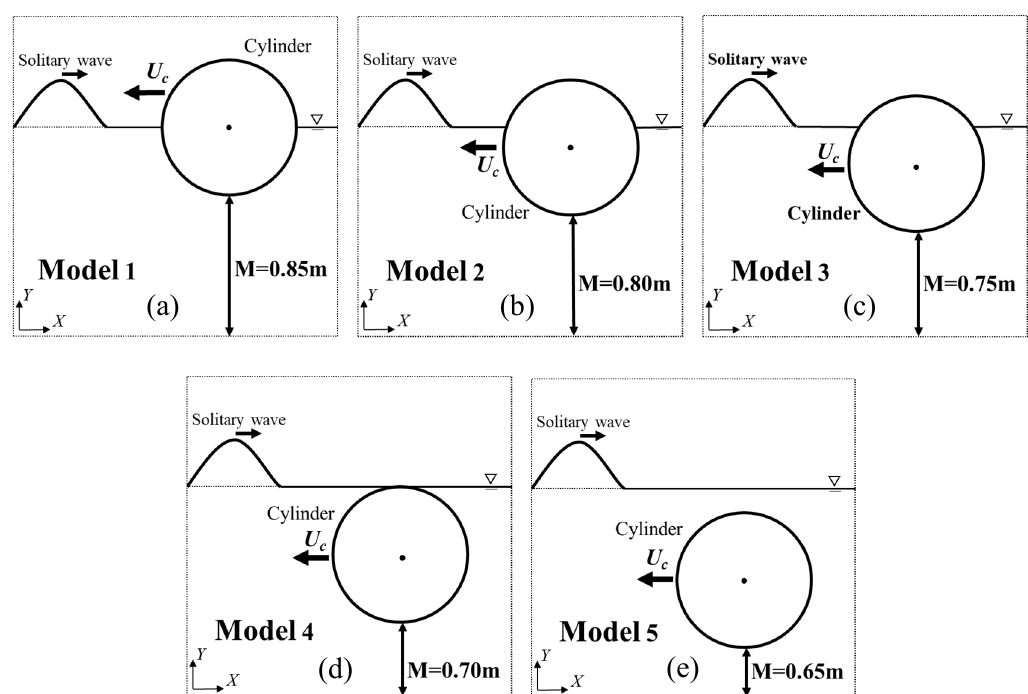
Figure 1. Schematic diagram of the numerical wave tank (NWT).